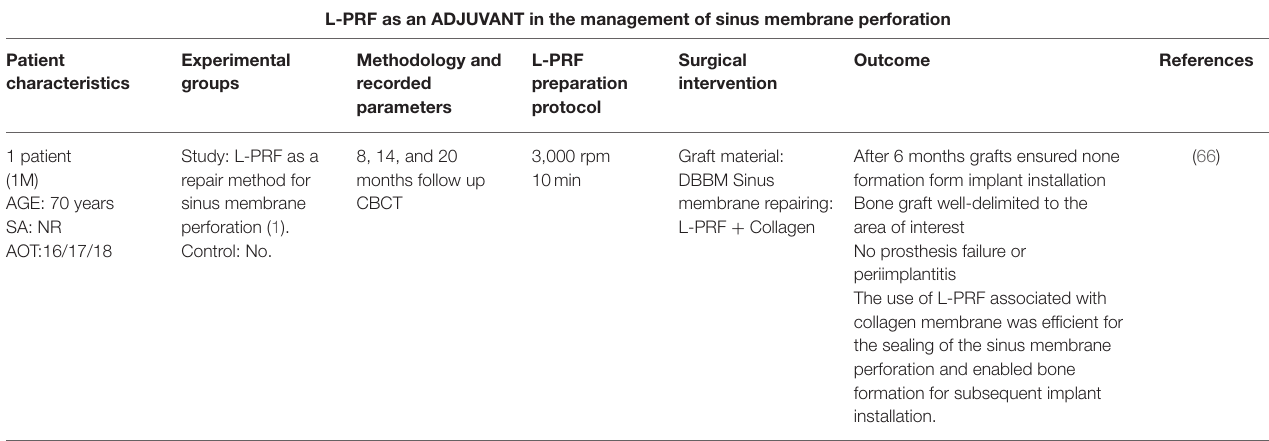
TABLE 4 | Studies on L-PRF and maxillary sinus augmentation with L-PRF as an adjuvant in the management of sinus membrane perforation. L-PRF as an ADJUVANT in the management of sinus membrane